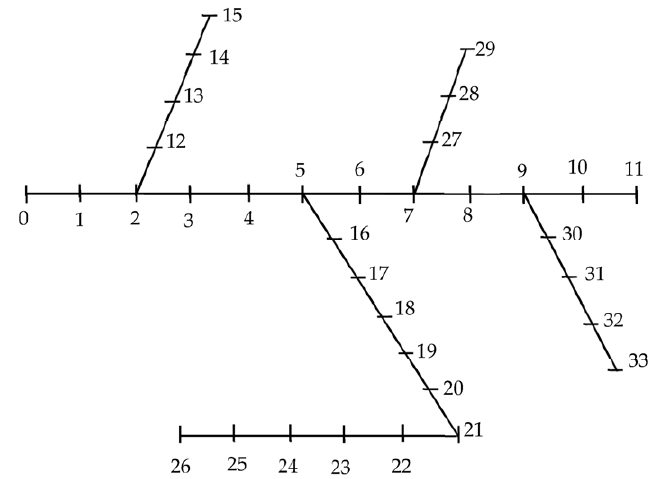
Figure 2. IEEE 34-bus distribution network test system [19].